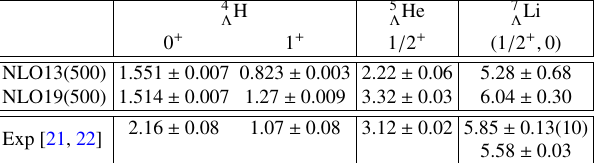
Table 1: B Λ for the A = 4 − 7 hypernuclei computed for the YN potentials NLO13(500) and NLO19(500) including the CSB interaction. The SMS N 4 LO + (450) and N 2 LO(450) are used to de- scribe the 2N and 3N interactions, respectively. All the employed potentials are evolved to a SRG parameter of λ = 1 . 88 fm -1 . SRG-induced YNN forces are explicitly taken into account. All energies are given in